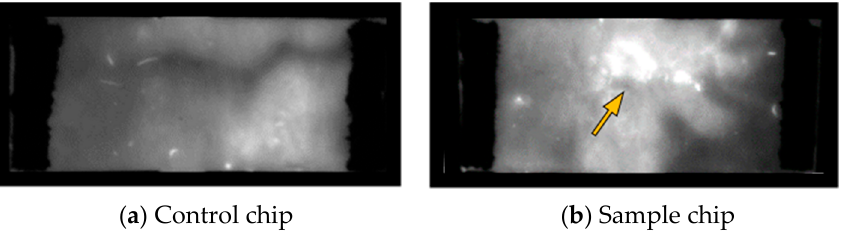
Figure 10. Purification of genomic DNA from cell lysate. ( a ) Staining of a control chip without DNA but lysis buffer as a sample with GelRed showing no fluorescent spots. ( b ) Fluorescent spots indicating the genomic DNA after fiber-electrophoresis with measurement setup 2 of a cell lysate from Legionella pneumophila Philadelphia stained with GelRed.